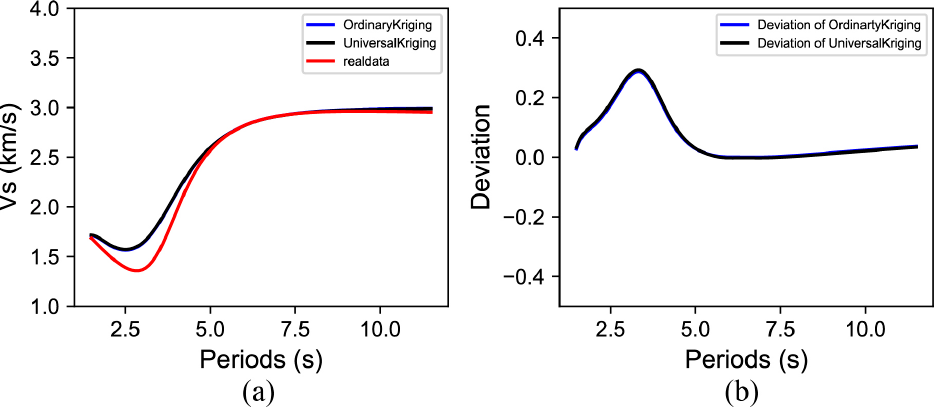
Figure A7. Comparison of dispersion curve interpolation results (128.18° E, 42.18° N ). The blue curve indicates the ordinary kriging results, while the black curve indicates those of universal kriging: ( a ) Comparison of the dispersion curves; and ( b ) deviation of the OK (blue) or UK (black) results.